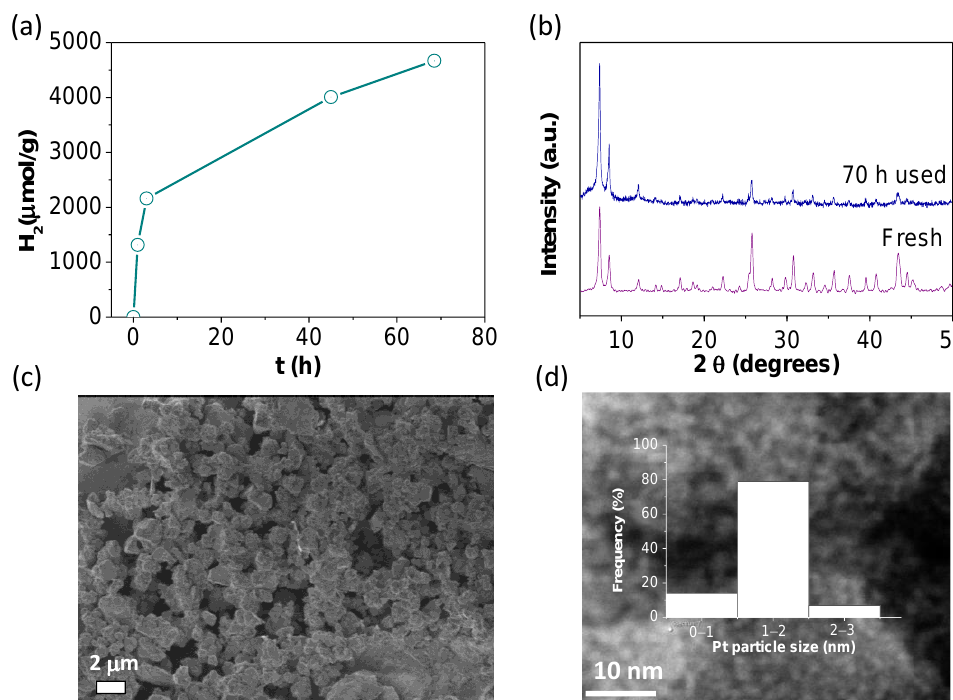
Figure 9. ( a ) H 2 evolution reaction after 70 h. ( b ) XRD patterns to confirm the stability of Pt@UiO-66(Zr)-NH 2 . ( c ) Representative SEM and DF-STEM images of used Pt@UiO-66(Zr)-NH 2 together with platinum particle size distribution ( d ). Reaction conditions: Photocatalyst (5 mg), H 2 O:glycerol mixture (20 mL; 14 vol%), reaction time as indicated, simulated sunlight irradiation (230 W/cm 2 ), 35 °C.